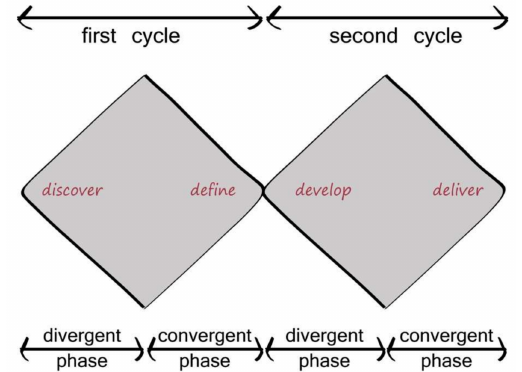
Figure 7. A representation of the double diamond design process model. From left to right, it depicts two design cycles (rhomboids) with a divergent and a convergent phase each. During the first cycle, the divergent phase is a generative ideation stage where the design space is opened and possibilities are explored. A convergent phase follows, where ideas are polished, defined, and prioritized. Some of these pass on to the second cycle, where they are further explored (divergent phase) first, and then concretized in a final convergent phase, ending in a concrete design